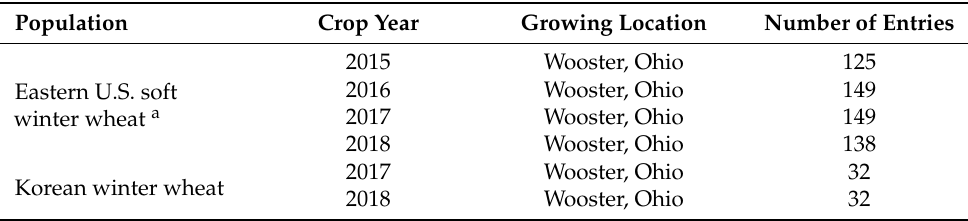
Table 5. Populations evaluated for heading